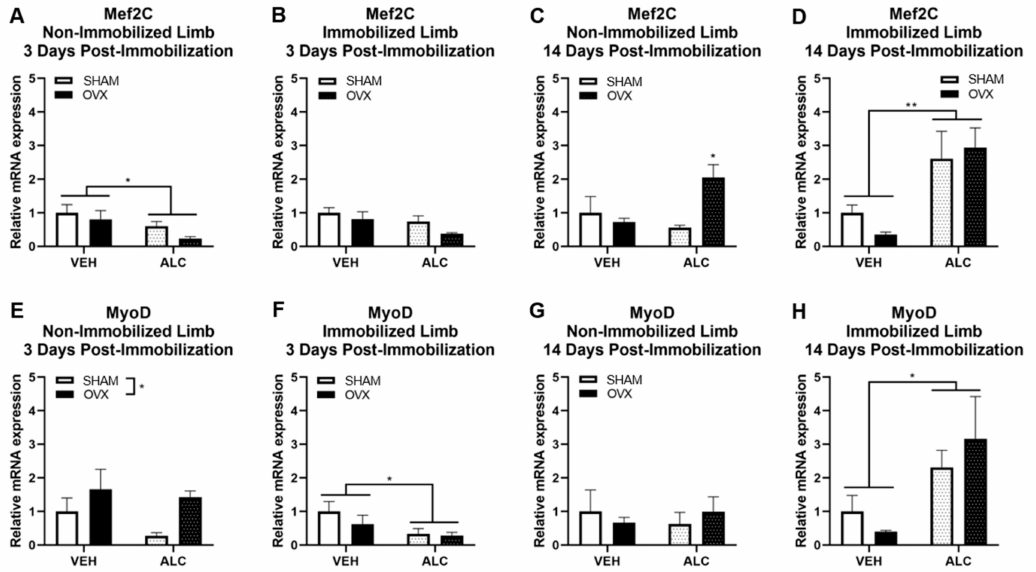
Figure 3. mRNA expression of myogenic genes in vastus lateralis muscle: myogenic enhancer factor 2C (Mef2C) after three days of post-immobilization recovery in the nonimmobilized ( A ) and immobilized ( B ) hind limb, Mef2C after 14 days of post-immobilization recovery in the nonimmobilized ( C ) and immobilized ( D ) hind limb, myoblast determination protein 1 (MyoD) after three days of post-immobilization recovery in the nonimmobilized ( E ) and immobilized ( F ) hind limb, and MyoD after 14 days of post-immobilization recovery in the nonimmobilized ( G ) and immobilized ( H ) hind limb with or without alcohol (ALC) and ovariectomy (OVX). Data analyzed by two-way ANOVA (alcohol × ovariectomy), * p < 0.05, ** p < 0.01, Mean ±